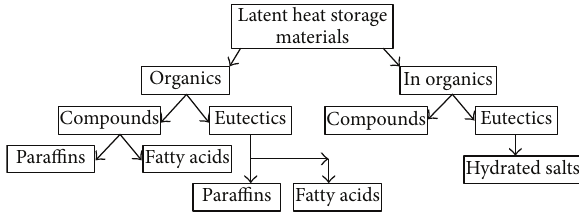
Figure 1: Classifications of phase change materials. Table 1: Properties of phase change